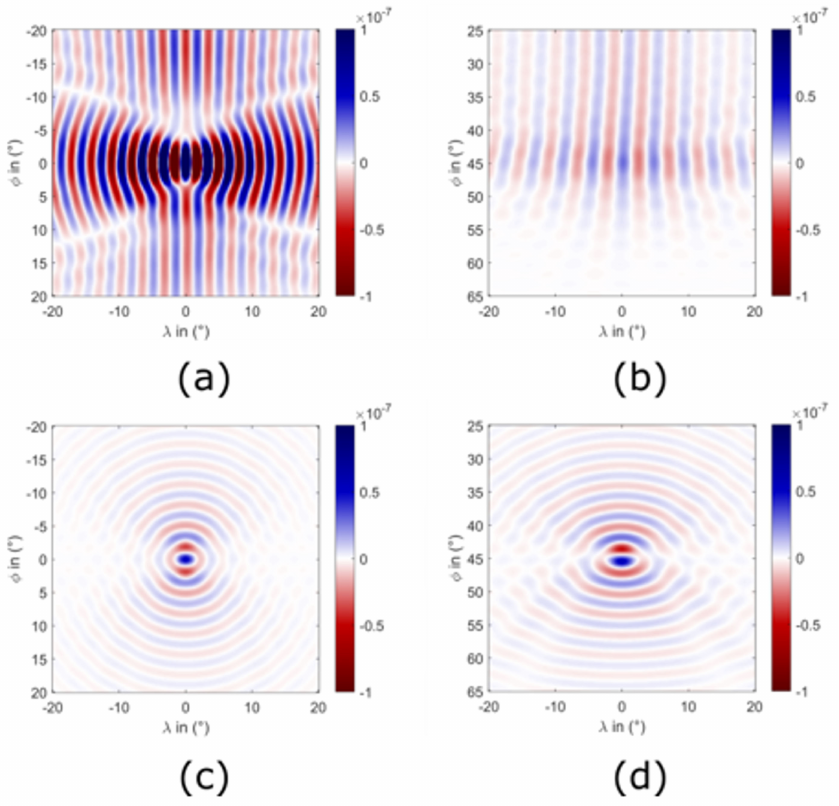
Figure 7. Spatial covariance functions in m 2 for the equator ( a , c ), and for 45 ◦ latitude ( b , d ), for the low–low pair formation ( a , b ), and the MOBILE constellation ( c , d